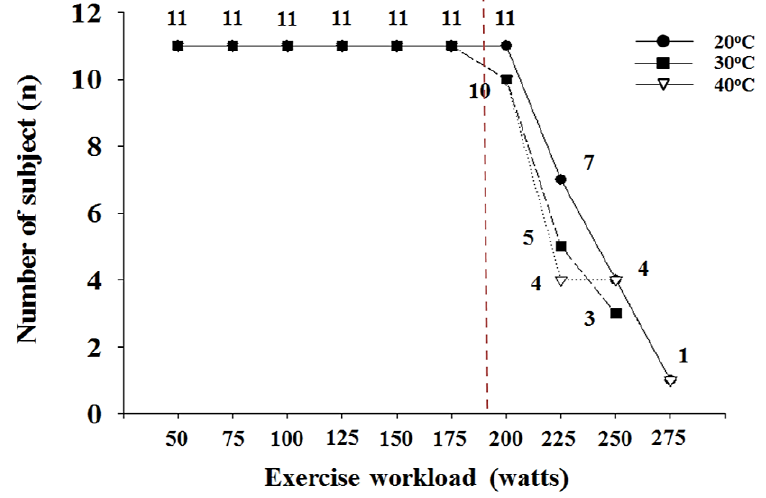
Figure 2. The end of graded exercise test at each environmental condition in all subjects.